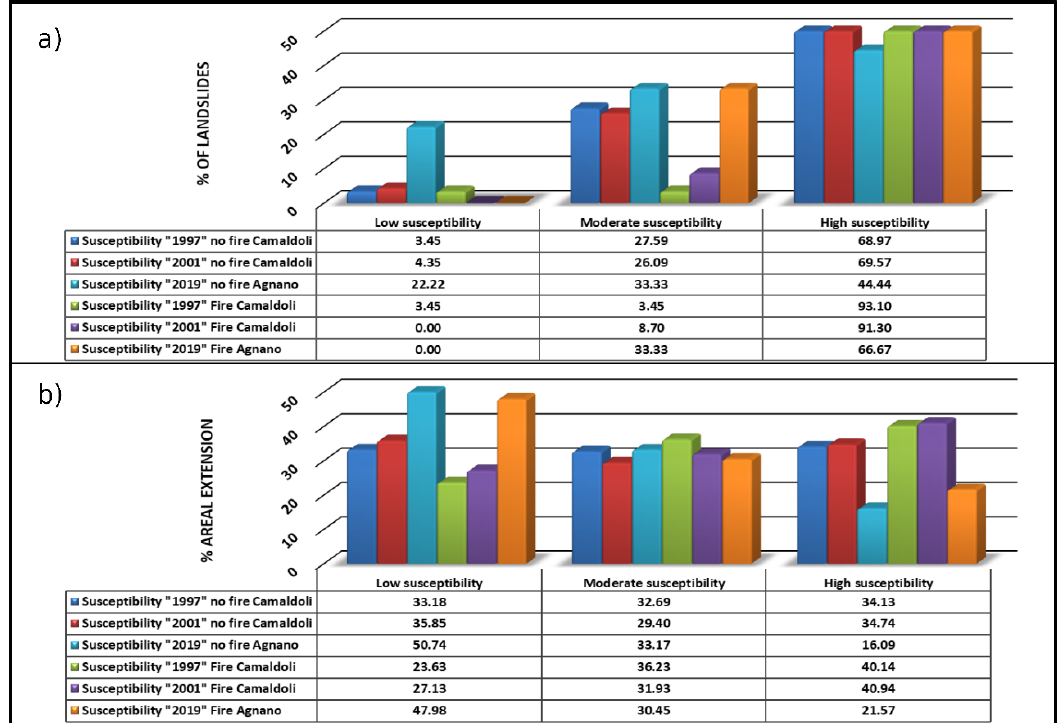
Figure 9. ( a ) Percentage of landslides falling in pre- and post-fire susceptibility maps; ( b ) percentage of pre- and post-fire areal extension. Table 7. Variables’ importance for the ensemble models. Green columns refer to the ensemble methods applied without the wildfire variable, blue columns also include the wildfire variable.